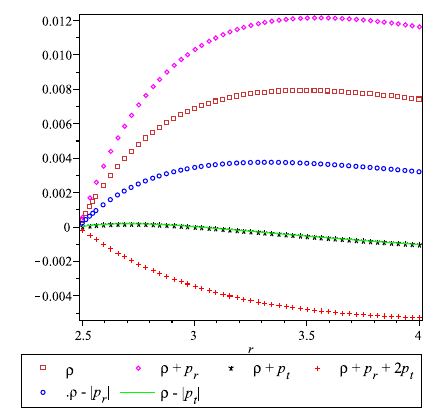
(h) This figure depicts the behavior of all EC terms